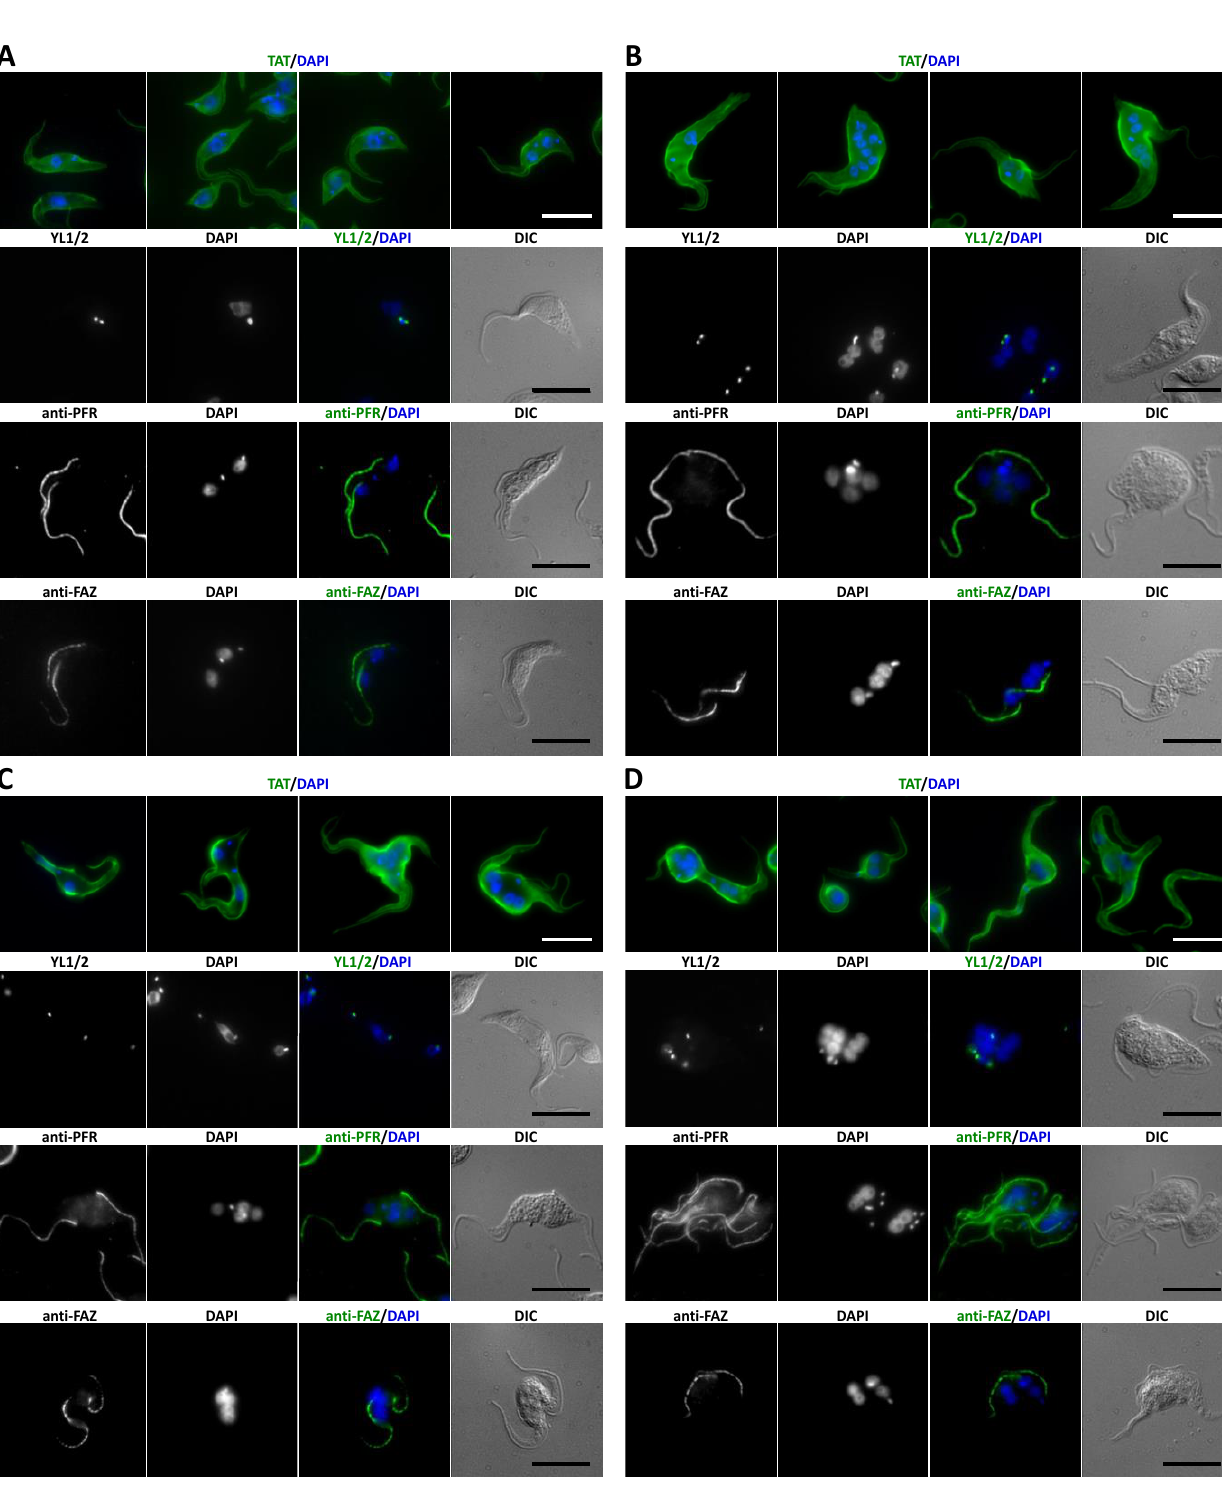
Figure 4. Immunofluorescence analysis of procyclic cells depleted of CAP52 ( B ) CAP42 ( C ) and CAP50 ( D ) by RNAi compared to wild-type 29-13 cells ( A ). Cells were doxycycline-induced for 3 days and fixed with methanol. TAT: anti- α -tubulin, YL1/2: anti-tyrosinated- α -tubulin (marker for basal bodies), PFR: anti-paraflagellar rod proteins A/C (L13D6), FAZ: anti-flagellum attachment zone (L3D2). DNA was stained with DAPI. Scale bar = 10 µm.